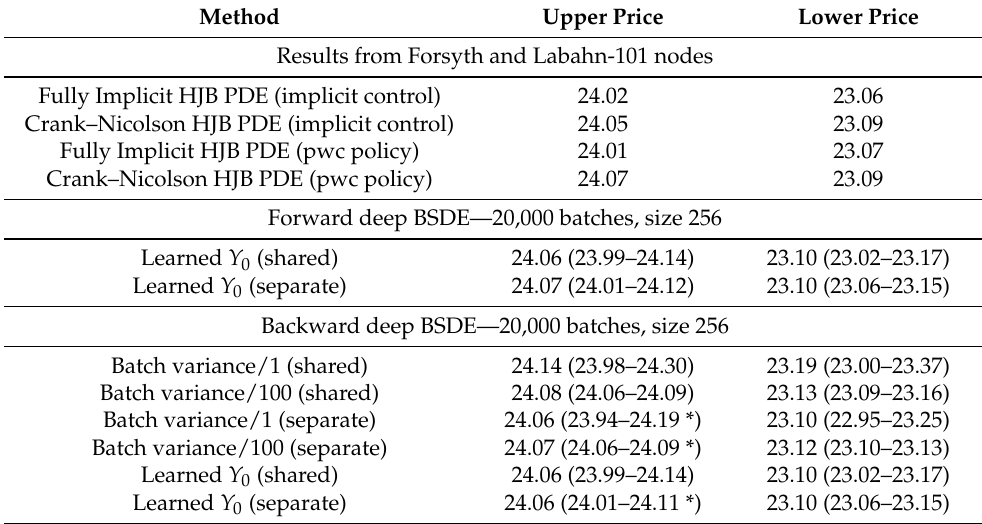
Table 1. Different pricers. * Means that Taylor is different by 0.01. Fixed X 0 . Y 0 range over every 100 in the last 1000 in parentheses. Middle of range as price.